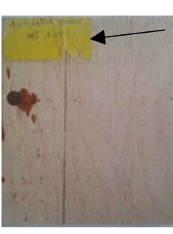
Figure 1. Acetylated birch plywood with an acetyl content of 30% from the 1945 research program was found in the FPL wood